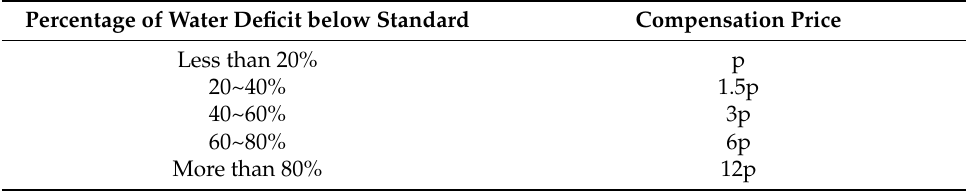
Table 4. The scheme of compensation for